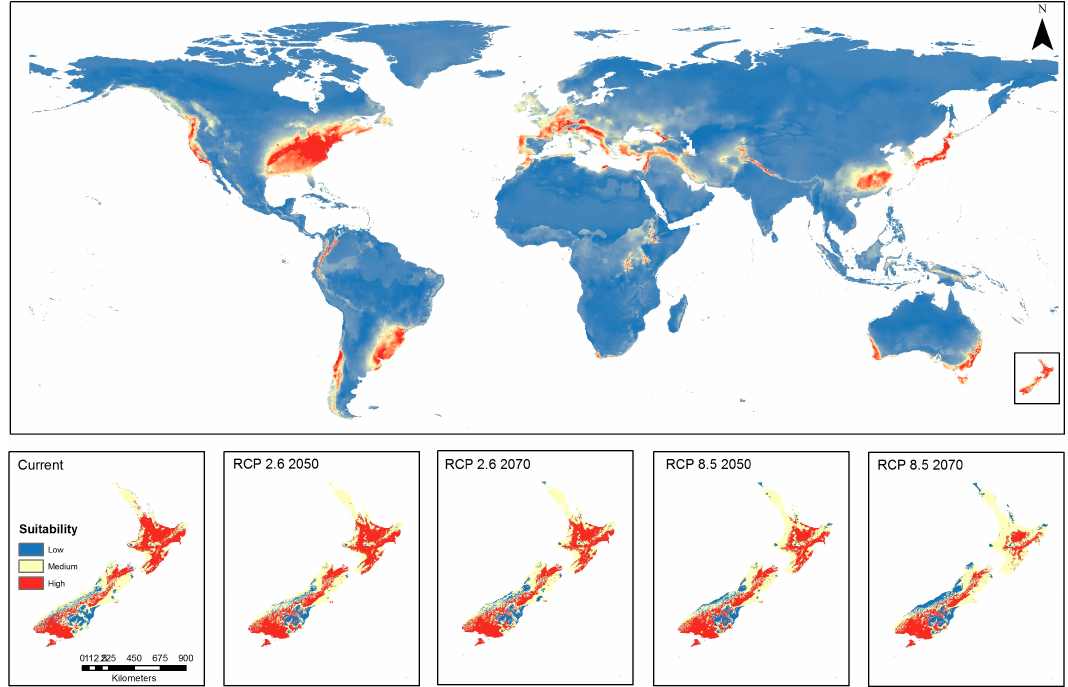
Figure 5. Global and New Zealand predictions of brown marmorated stink bug habitat suitability under current conditions and emissions trajectories of Representative Concentration Pathways (RCP) 2.6 and RCP 8.5 for the years 2050 and 2070 using combined ensemble algorithm (Random Forest, Support Vector Machine and Maxent).